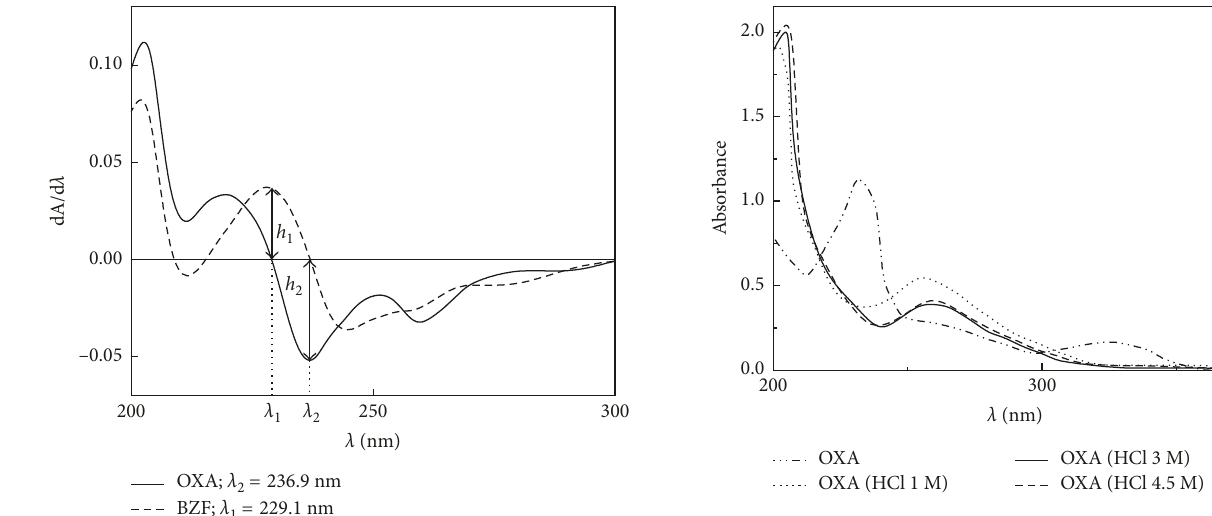
5 M. 3.02 10 (cid:30) × −